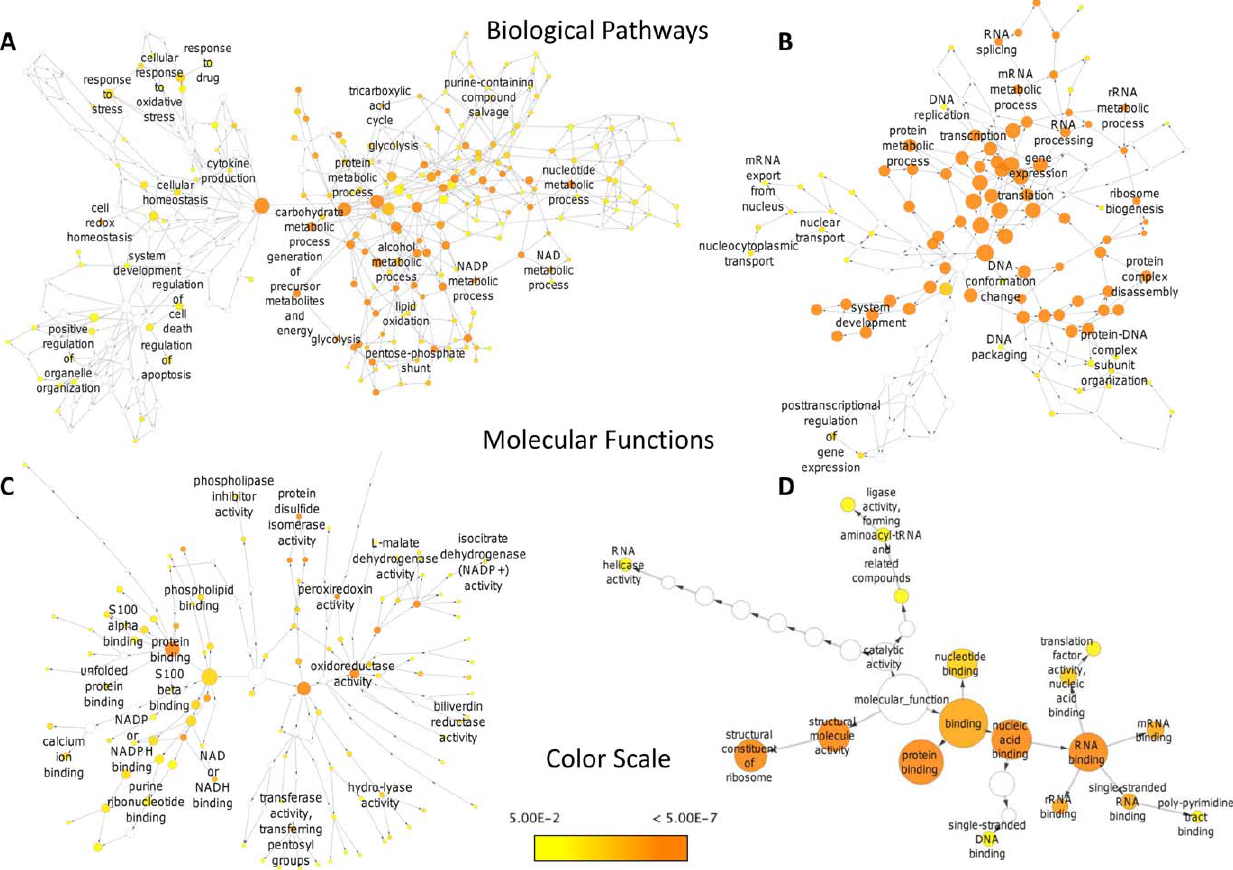
Figure 5. Biological pathway and molecular function networks. BiNGO [14] generated biological pathway and molecular function networks for proteins with significantly altered expression levels associated with cisplatin resistance. Node size is related to the number of proteins associated with a GO term, while the color relates to the p-value for the statistical significance of the enrichment of a GO term . Interactive Cytoscape networks are included as Dataset S1 .